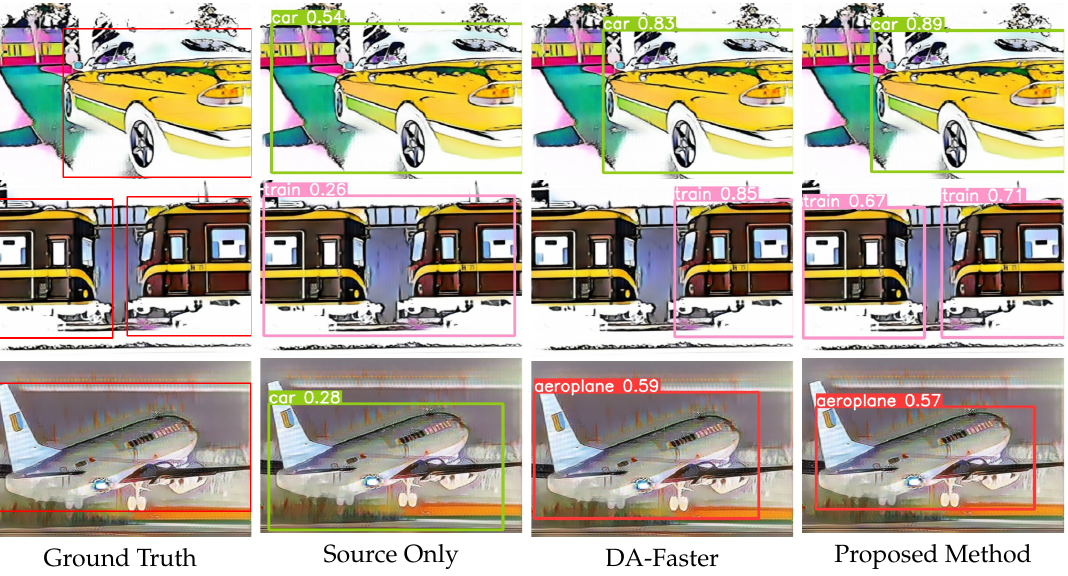
Figure 13. Qualitative results (Pascal VOC → DT Clipart). The Pascal VOC dataset is used as source domain, and the DT Clipart dataset is used as target domain. From left to right are the results from ground truth, source only, DA-Faster, and proposed